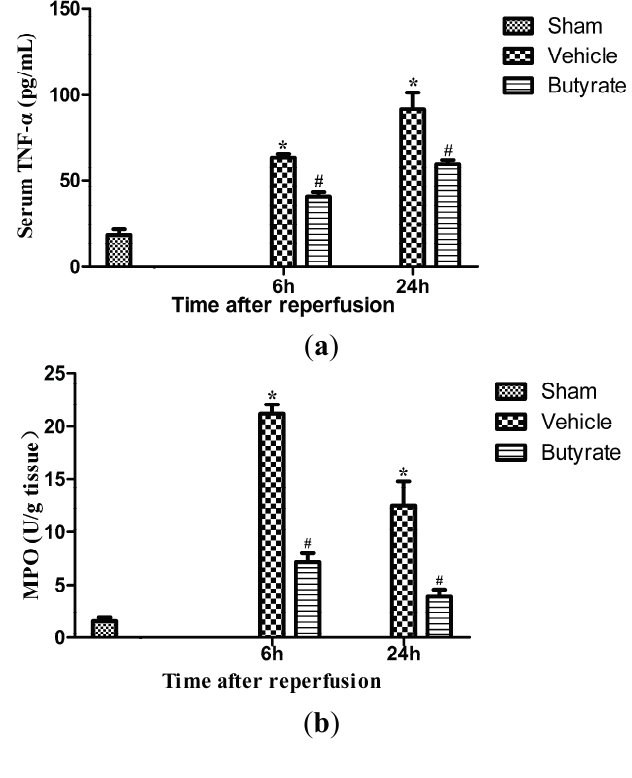
Figure 3. Serum tumor necrosis factor α (TNF- α ) ( a ) and liver myeloperoxidase (MPO) ( b ) activities at 6 and 24 h after reperfusion. Serum TNF- α and liver MPO activities were significantly increased in the vehicle group, which were markedly reduced by butyrate administration. Data represent means ± SD, n = 4–5 rats per group. * p < 0.05 vs. the sham group, # p < 0.05 vs. the vehicle